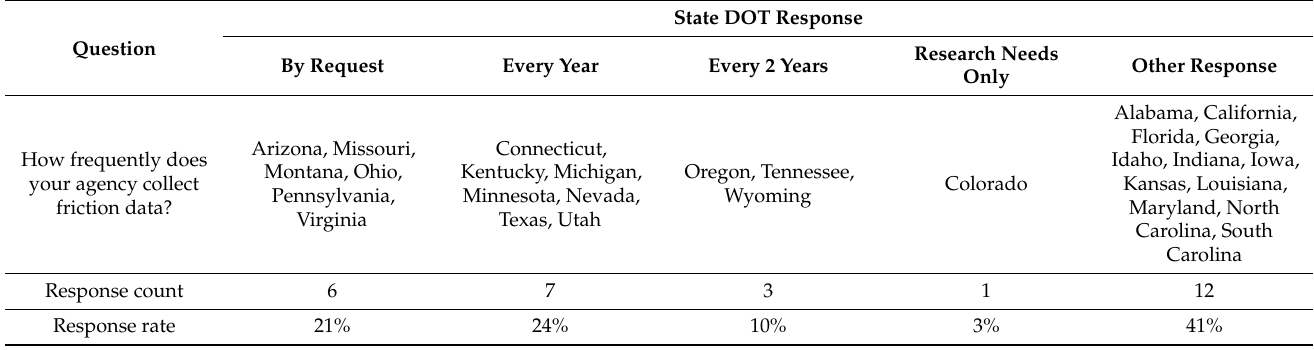
Table 4. Pavement friction data collection frequencies.